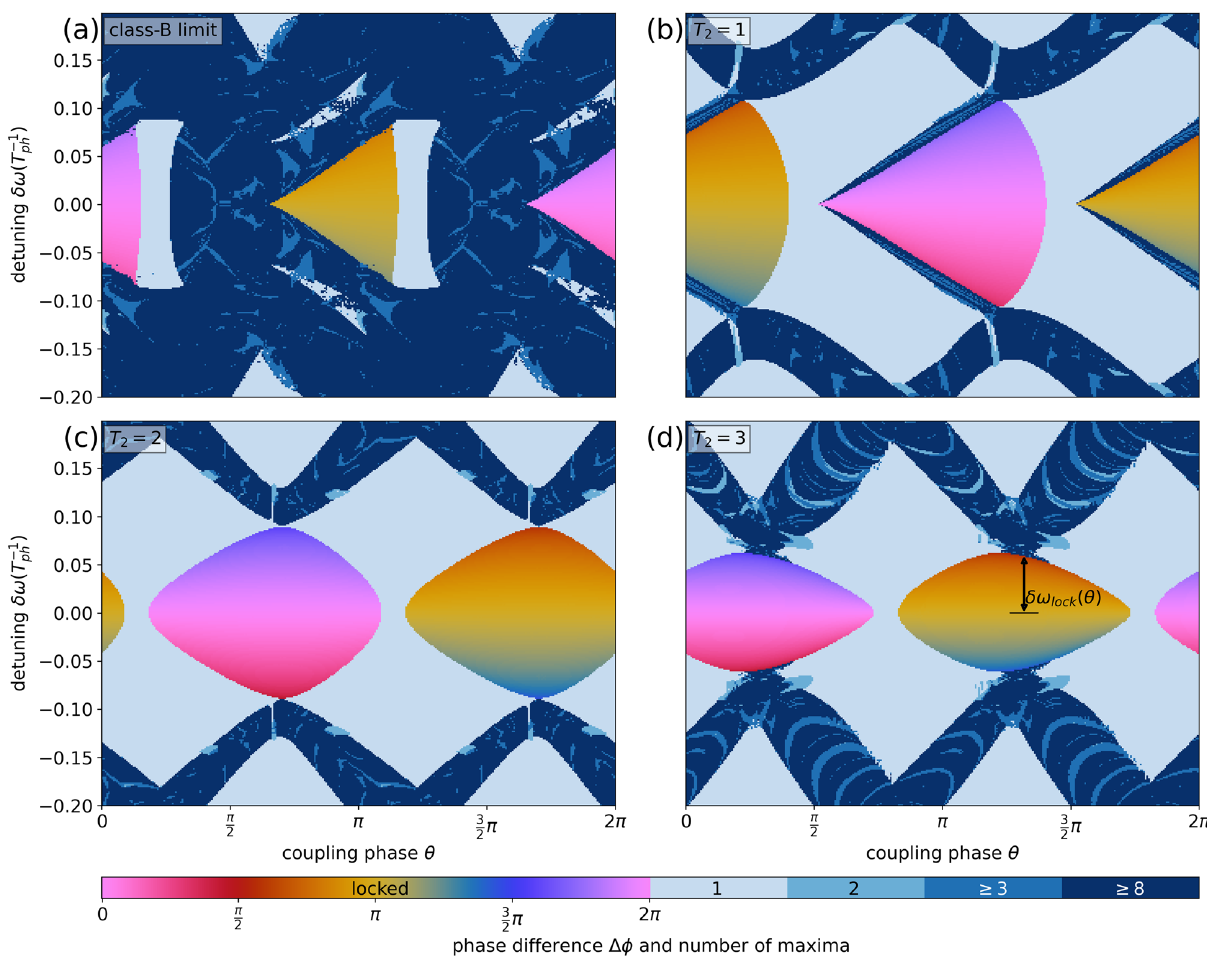
Figure 6. Two dimensional bifurcation scenarios in the (θ , δω) -parameter space. For each data point the maxima of one time series of one laser are counted and color coded in blue. In the locked regions the phase difference of the electric fields of the lasers is shown by the pink and yellow color code. From ( a ) to ( d ) the polarization lifetime T 2 increases. Other parameters are �ω = 3 , p = 2 , K = 0.1 , τ = 10 , T = 392